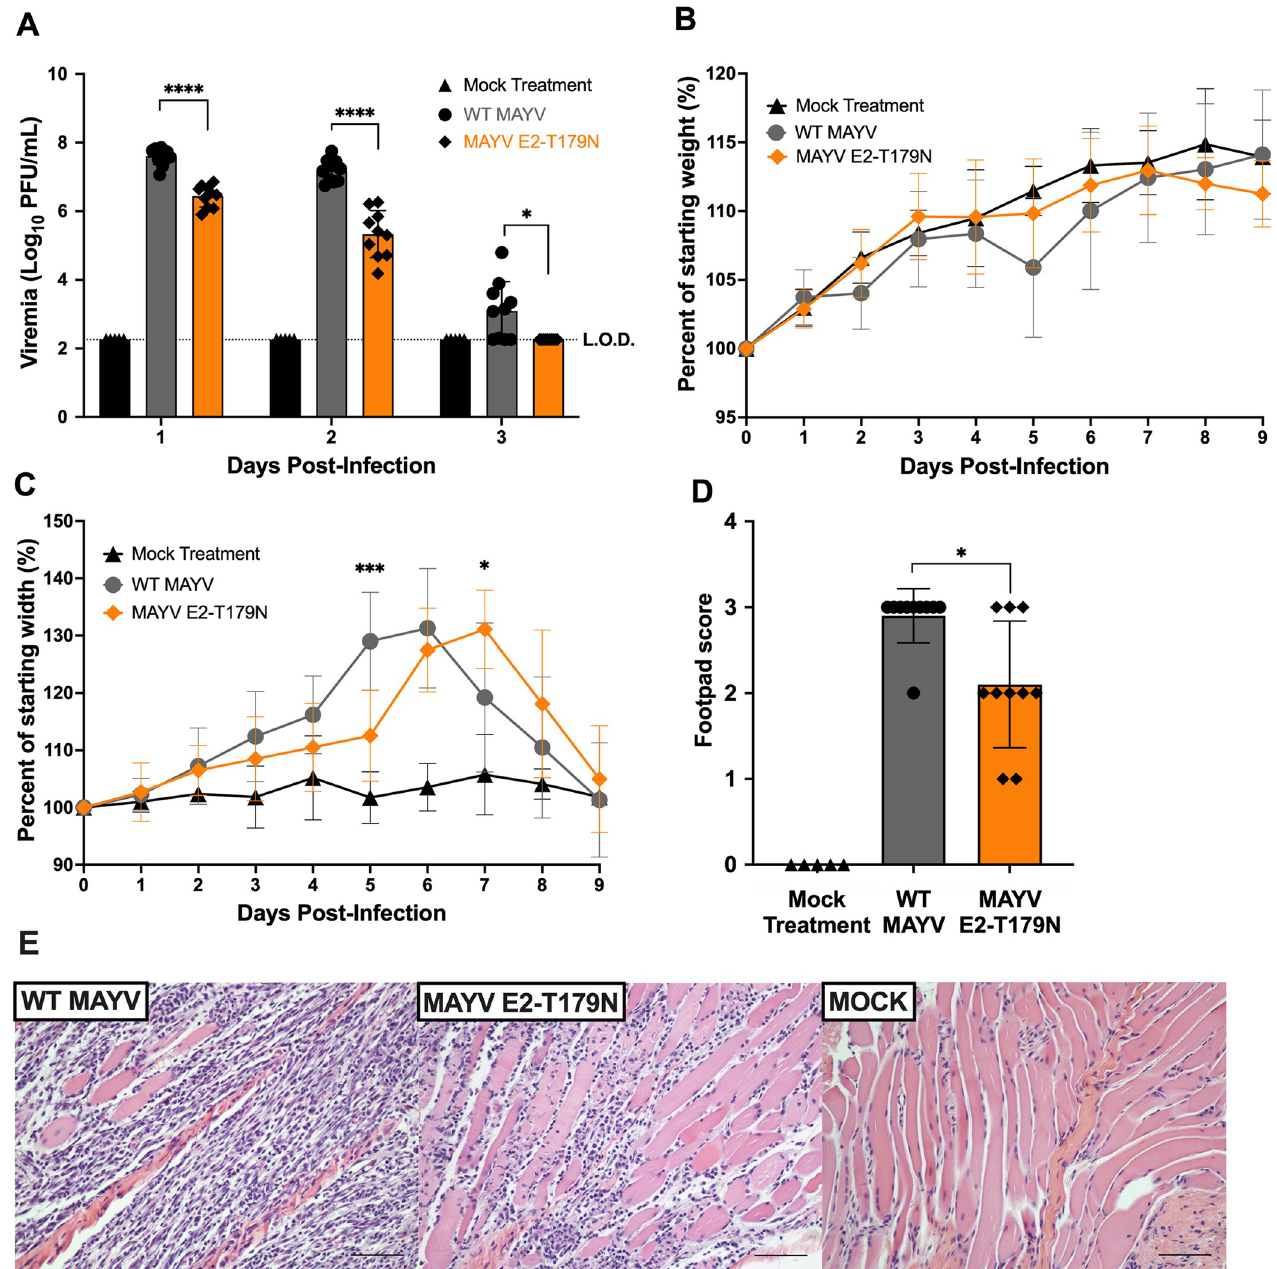
Fig 6. E2-T179N attenuates MAYV replication and tissue pathology in mice. Four-week-old CD-1 mice were infected with 10 5 PFU in 50 μ L via injection to the left, hind footpad. A: Viral load in serum was assessed daily by plaque assay. Statistical comparisons were made using multiple unpaired t tests with correction for multiple comparisons using the false discovery rate method of Benjamini, Krieger, and Yekutieli. B : Mice were weighed daily following infection to assess weight change. C: Footpad swelling was measured daily using a digital caliper. B-C: Statistical comparisons were made using a two-way ANOVA with Dunnett’s correction for multiple comparisons. Data represent the percent of the weight or footpad width before infection. D: Footpad swelling score as determined by histopathology whereby a score of 0 indicates a normal state, 1 mild ( < 25%) myofiber loss, 2 moderate (25–50%) myofiber loss, and 3 severe ( > 50%) myofiber loss. Statistical comparisons were made by Mann-Whitney test. E: Hematoxylin and eosin stain of muscular tissue in left, hind footpad of mice seven days post infection with WT MAYV (left), MAYV E2-T179N (center) or after a mock treatment (right). Footpad scores of 3 and 1 are shown for images of WT MAYV and MAYV E2-T179N, respectively. The scale bar in the images is 200 microns. Studies were performed in two independent experiments, using 10 mice per infected group and five mock-treated mice. Error bars represent standard deviation from the mean.